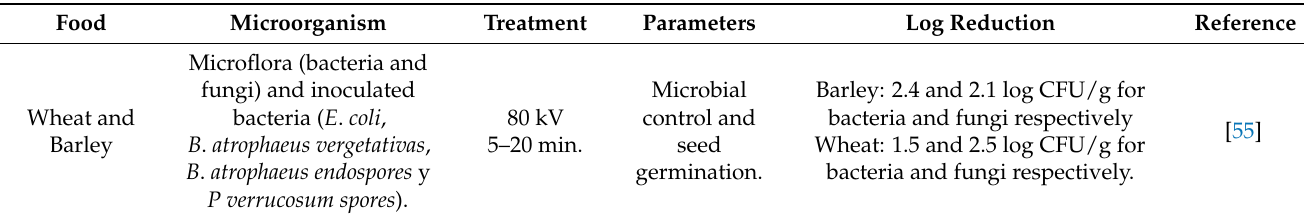
Table 4. Cereals treated with DBD at atmospheric pressure and ambient